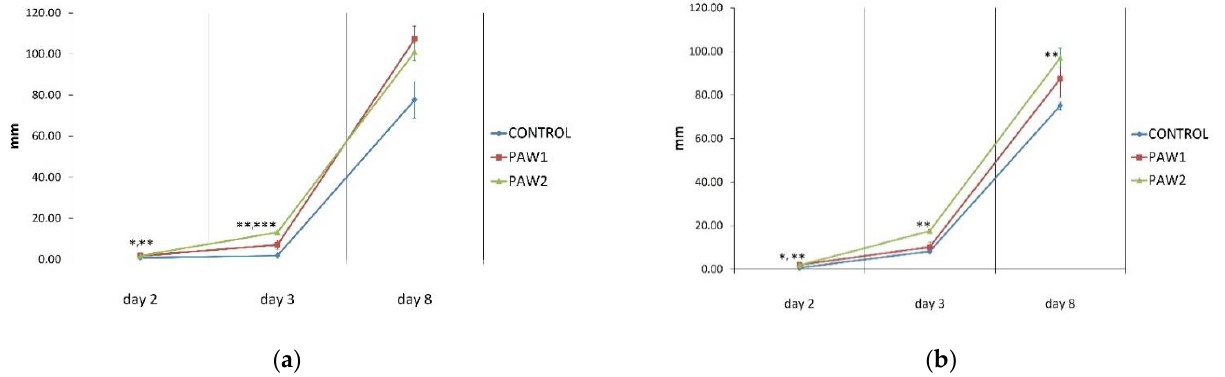
Figure 3. Effect of PAW treatment on the lengths of shoots ( a ) and roots ( b ) of Triticum aestivum L. cv. Glosa sprouts; * significant difference ( p < 0.05) between control and PAW1; ** significant difference ( p < 0.05) between control and PAW2; *** significant difference ( p < 0.05) between PAW1 and PAW2. Each point represents the mean ± SD of three determinations.